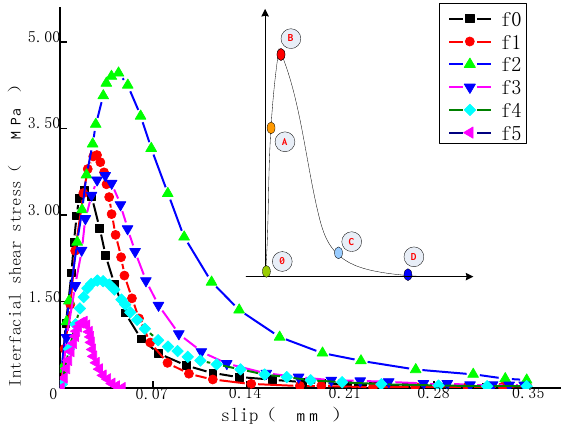
Figure 13. Interfacial constitutive relationship curve.